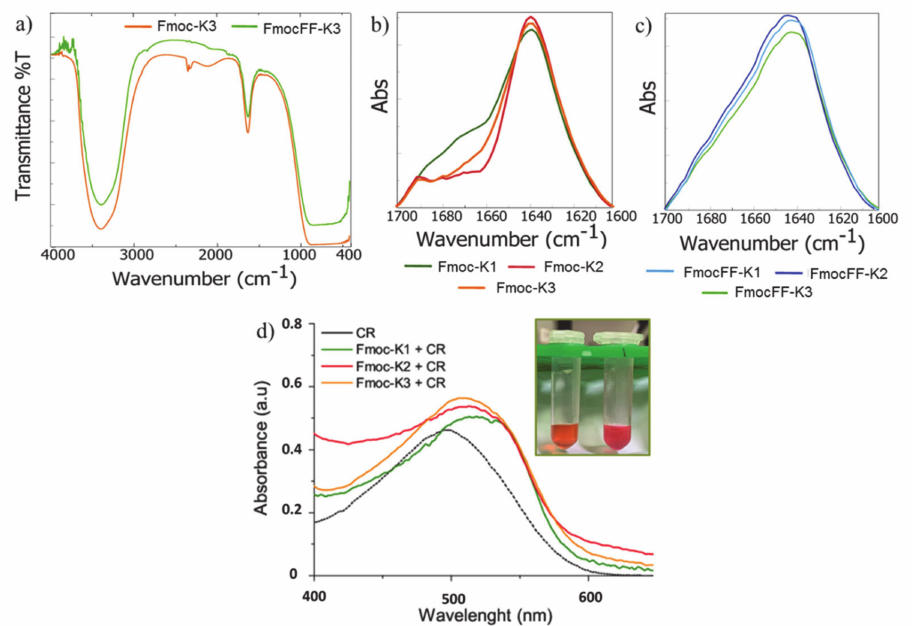
Figure 4. ( a ) FTIR spectra of Fmoc-K3 and Fmoc-FFK3. Absorbance deconvolution in the amide I region for: Fmoc-K1, Fmoc-K2, and Fmoc-K3 ( b ) and for FmocFF-K1, FmocFF-K2, and FmocFF-K3 ( c ). UV–Vis spectra of CR alone and co-incubated with hydrogels of the three Fmoc-K derivatives. ( d ) Macroscopical appearance of CR and Fmoc-K3+CR is reported in the